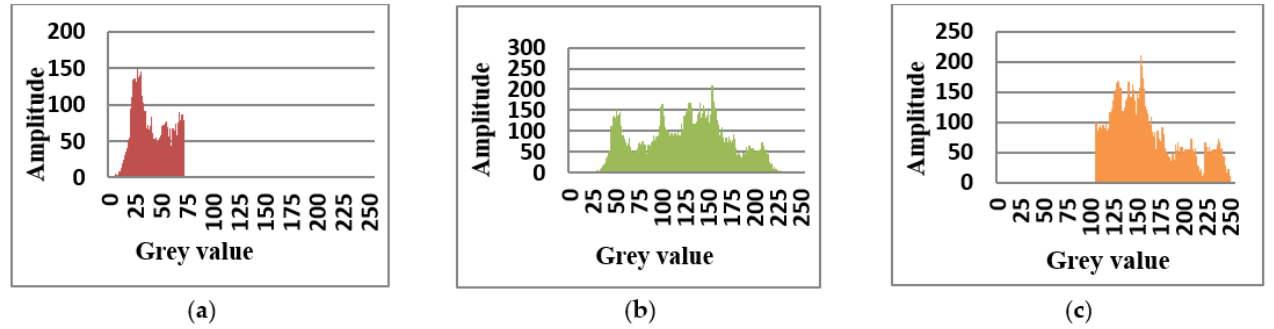
Figure 3. ( a ) low contrast, ( b ) normal contrast, and ( c ) high contrast. In low-contrast images, the histogram is shifted toward the right side. For high-contrast images, it is shifted toward the left side. Moreover, if the contrast is normal, the histogram bins are distributed in the middle of the histogram. Next, the histogram bins’ intensity distribution on the left side and right side of the peak value is determined, and the side where the pixel distribution is less than the zero points is selected, as shown in Figure 4.